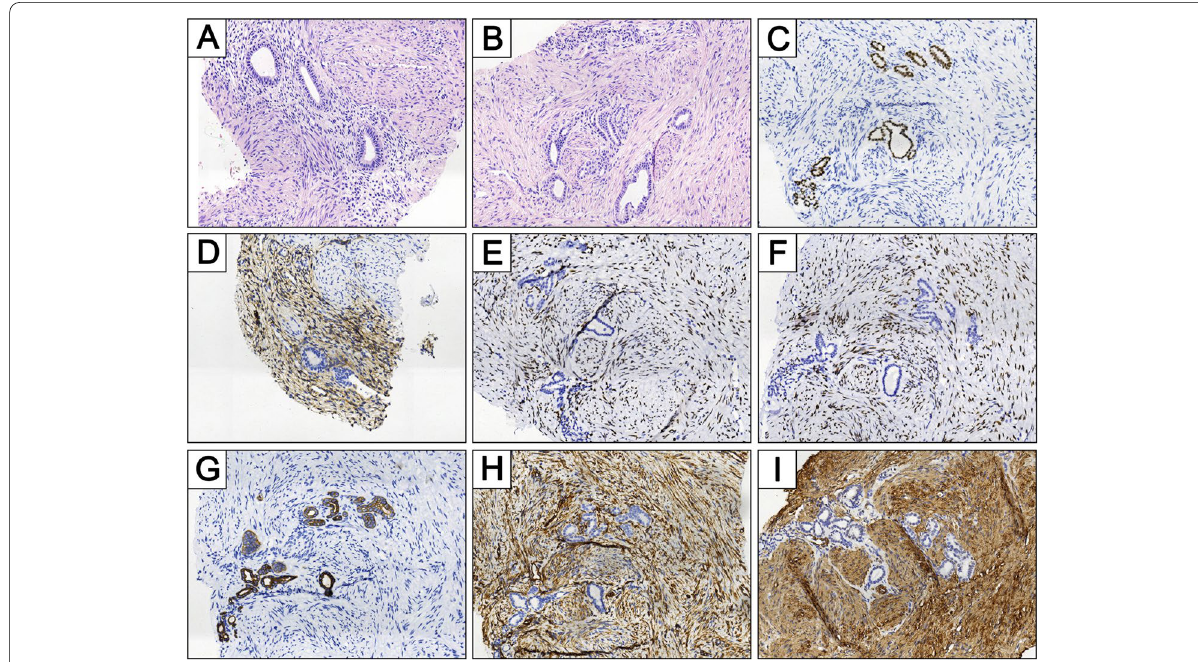
Fig. 3 MEST histopathology and IHC. A and B Representative H&E stains of the patient III:1, transcutaneous puncture biopsy of the kidney, demonstrating a mixture of epithelial and mesenchymal components. Columnar epithelial cells formed tubular glands. The most of mesenchymal component is composed of uterine smooth muscle-like cells. A small componet of mesenchyme nearby the glands resembled endometrial stromal cells. A is reminiscent of uterus adenomyosis. Positive immunohistochemical staining of epithelial cells for (C) PAX8 and (G) CK. Mesenchymal cell is positive for (E) ER, (F) PR, (H) Vim and (I) SMA. (D) Endometrial stromal-like cells surrounding the glands exhibited expression of